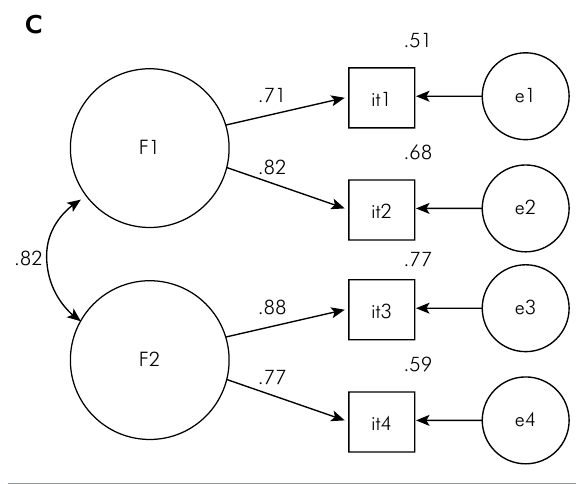
Figure 2. Two-factor model (Model C) of the Dental Anxiety Scale (DAS) (F1: anticipatory dental anxiety; F2: treatment dental